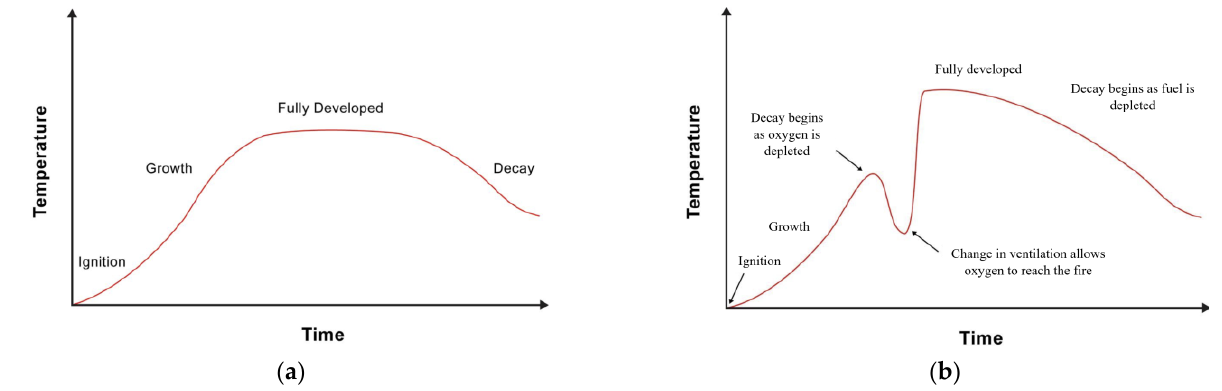
Figure 4. Idealized fire curve: ( a ) fuel-controlled; ( b )